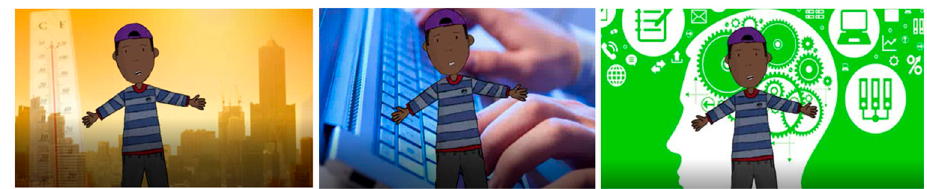
Figure 4. The image of Reza, as shown on the robot screen.